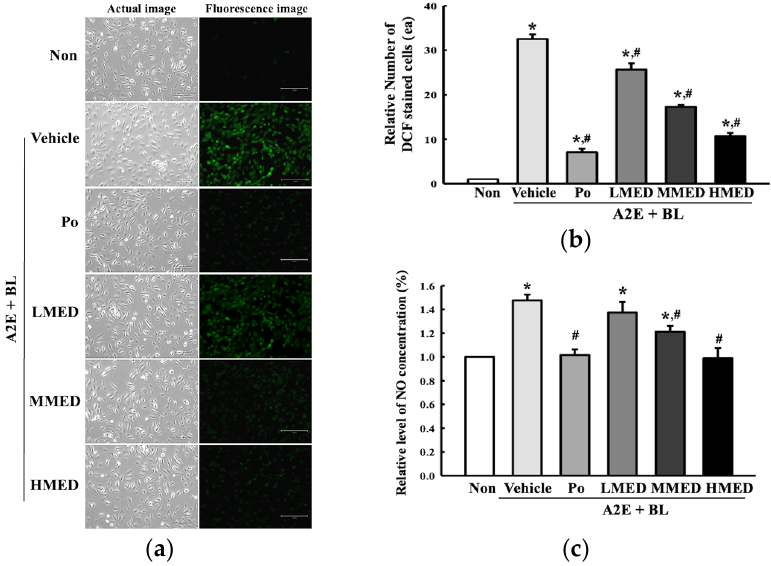
Figure 2. Detection of ROS and NO concentration in MED + A2E + BL treated ARPE19 cells. ( a ) Fluorescence image of DCF stained cells. The morphology of cells was detected using an optical and fluorescent microscope at 200 × magnification. ( b ) Number of DCF stained cells. ( c ) NO concentration. NO concentration in the culture supernatants was determined using Griess reagent. DCFH-DA staining and NO assay were conducted using three wells per group, and these assays for each sample were analyzed in duplicates. All values in results are represented as the means ± standard deviation (SD). * indicated statically significance compared to the Non treated group, while # indicated statically significance compared to the Vehicle + A2E + BL treated group. Abbreviations: ROS, reactive oxygen species; NO, Nitric oxide; DCFH-DA, 20,70-Dichlorofluorescin diacetate; MED, methanol extracts of Dipterocarpus tuberculatus Roxb.; A2E, N-retinylidene-N-retinylethanolamine; BL, Blue light.